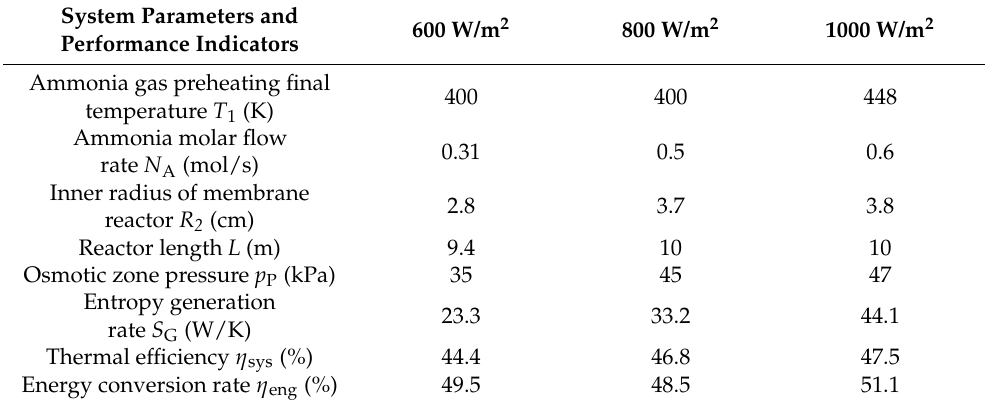
Table 3. Parameters of TOPSIS optimal system in three-objective optimization under different light